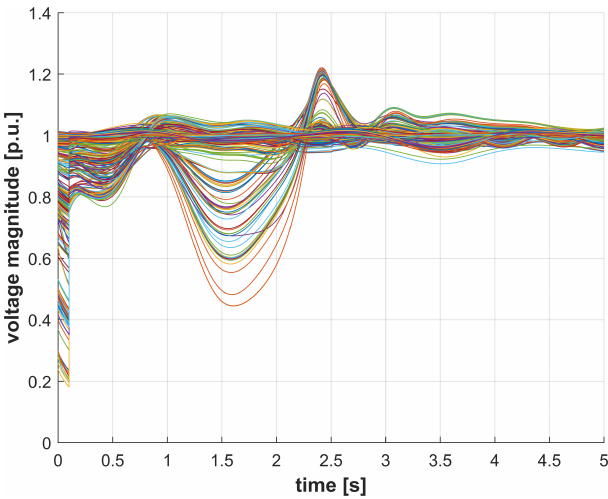
Figure 12. Voltage magnitude with D-FACTS